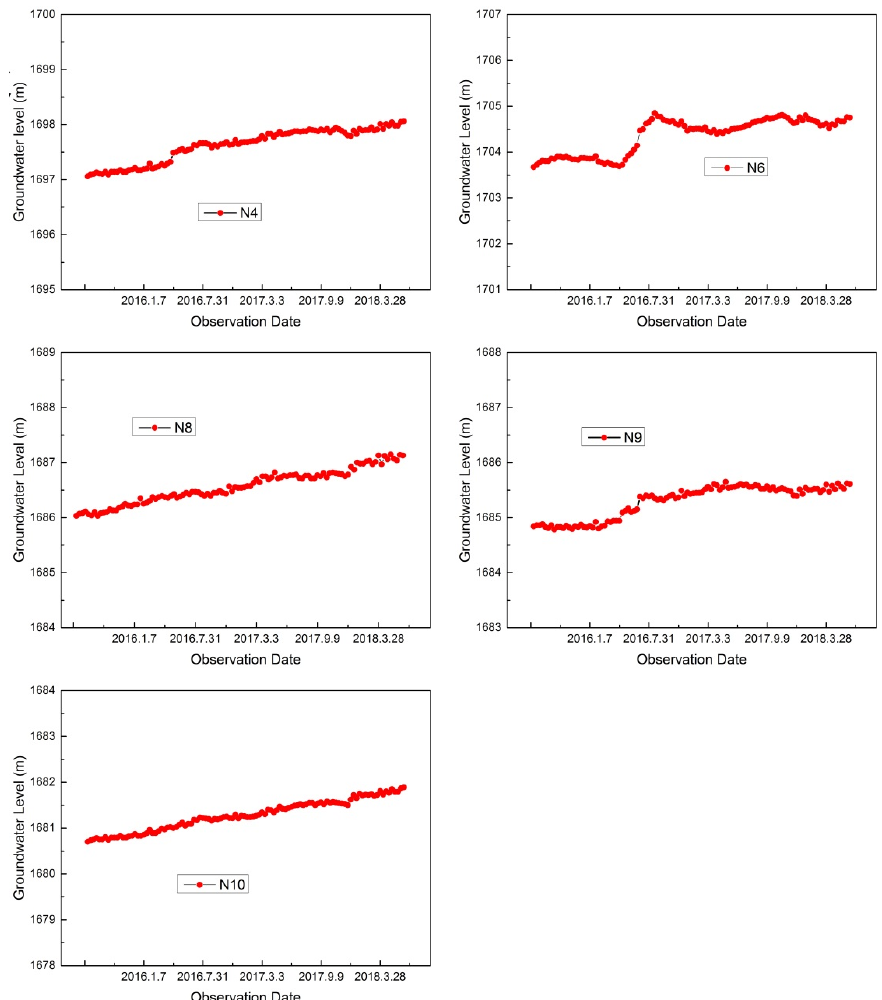
Figure 7. Variation of the groundwater level elevation with time at each observation hole.